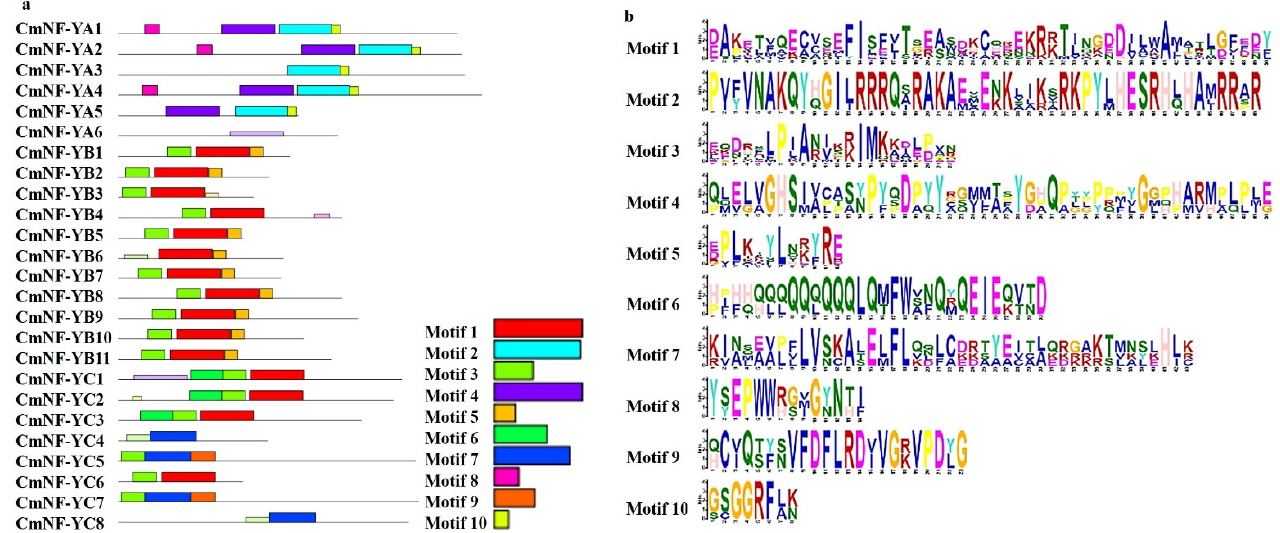
Figure 2. Conserved motifs prediction of CmNF-Y proteins using the MEME program. ( a ) Distribu- tion of CmNF-Y conserved motifs. The ten motifs were displayed in different colored boxes. ( b ) The sequence logos of ten conserved motifs.